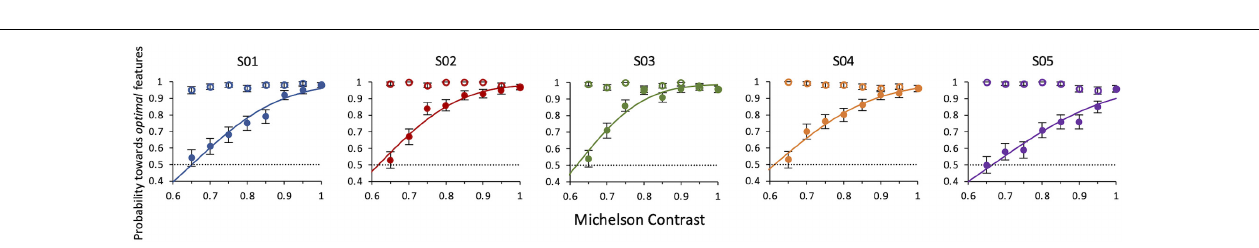
Frontiers in Neuroscience |